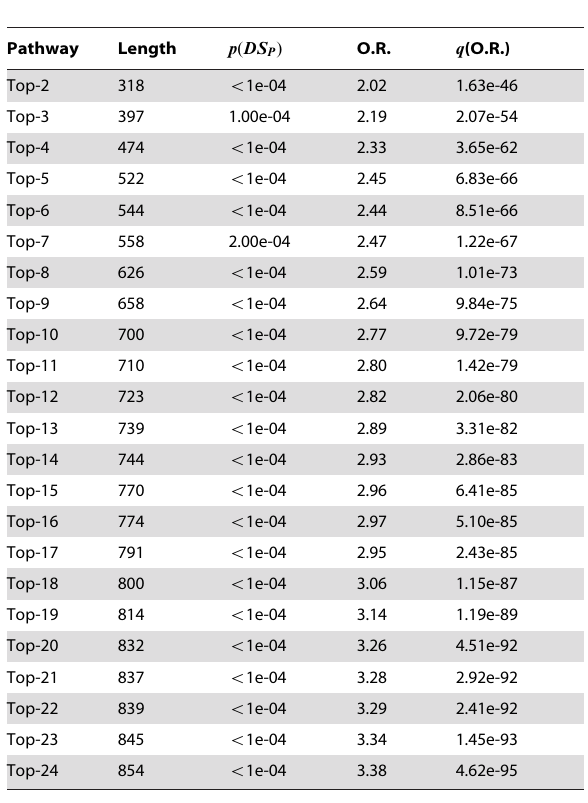
Table 4. PoDA results for sucessive unions of significant pathways in the CGEMS breast cancer data.